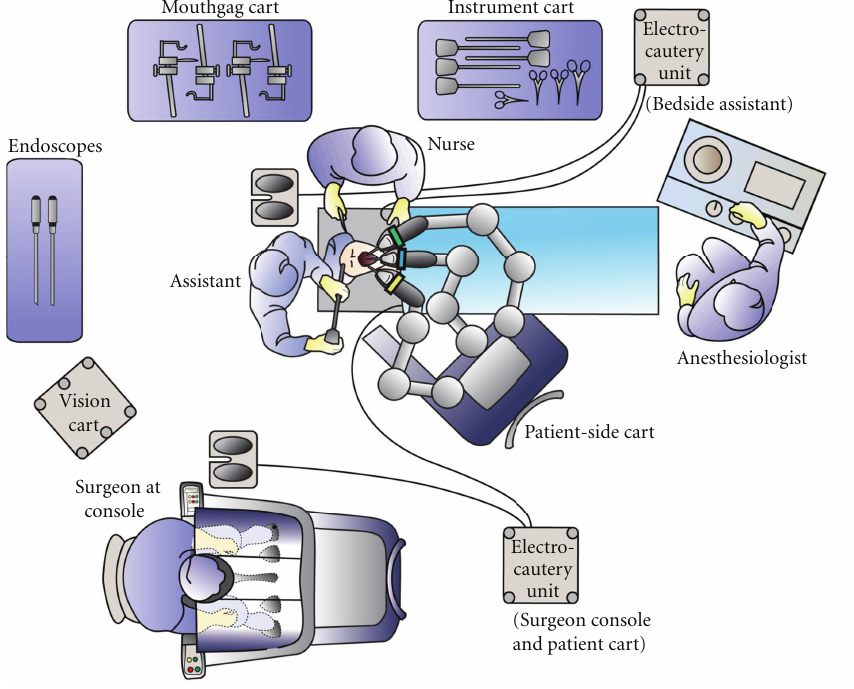
Figure 1: Operation room setup (Courtesy of Intuitive Surgical Inc.,